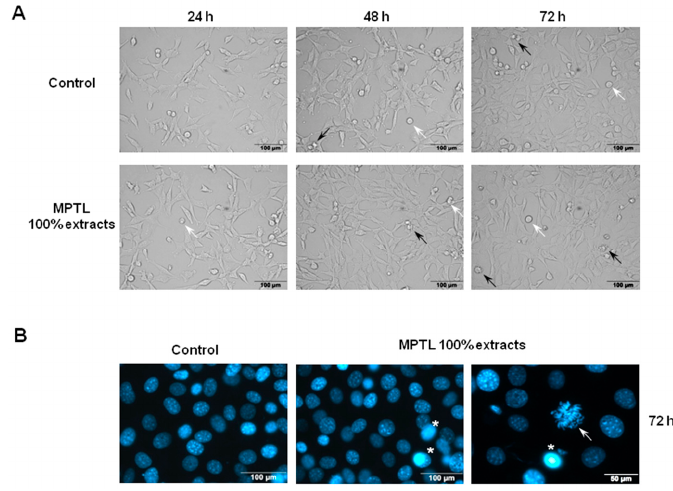
Figure 7. The effect of MPTL extracts on the: cellular ( A ); and nuclear ( B ) morphology of mouse embryonic fibroblast NIH 3T3 cells. ( A ) NIH 3T3 cells were exposed to 100% concentrated MPTL extract for the time indicated and examined under inverted microscope using ×20 objective. Apart from healthy, flattened adherent cells and detached round mitotic cells (white arrows), there were only few shrunken cells with blebbing membrane typical for apoptotic cell death (black arrows). ( B ) NIH 3T3 cells were exposed to 100% concentrated MPTL extract for 72 h and examined under fluorescence microscope using ×40 objective following staining with Hoechst 33342. Shrunken nuclei with intensely stained condensed and pycnotic chromatin were regarded as apoptotic (star). Arrow indicates cell with condensed chromosomes undergoing